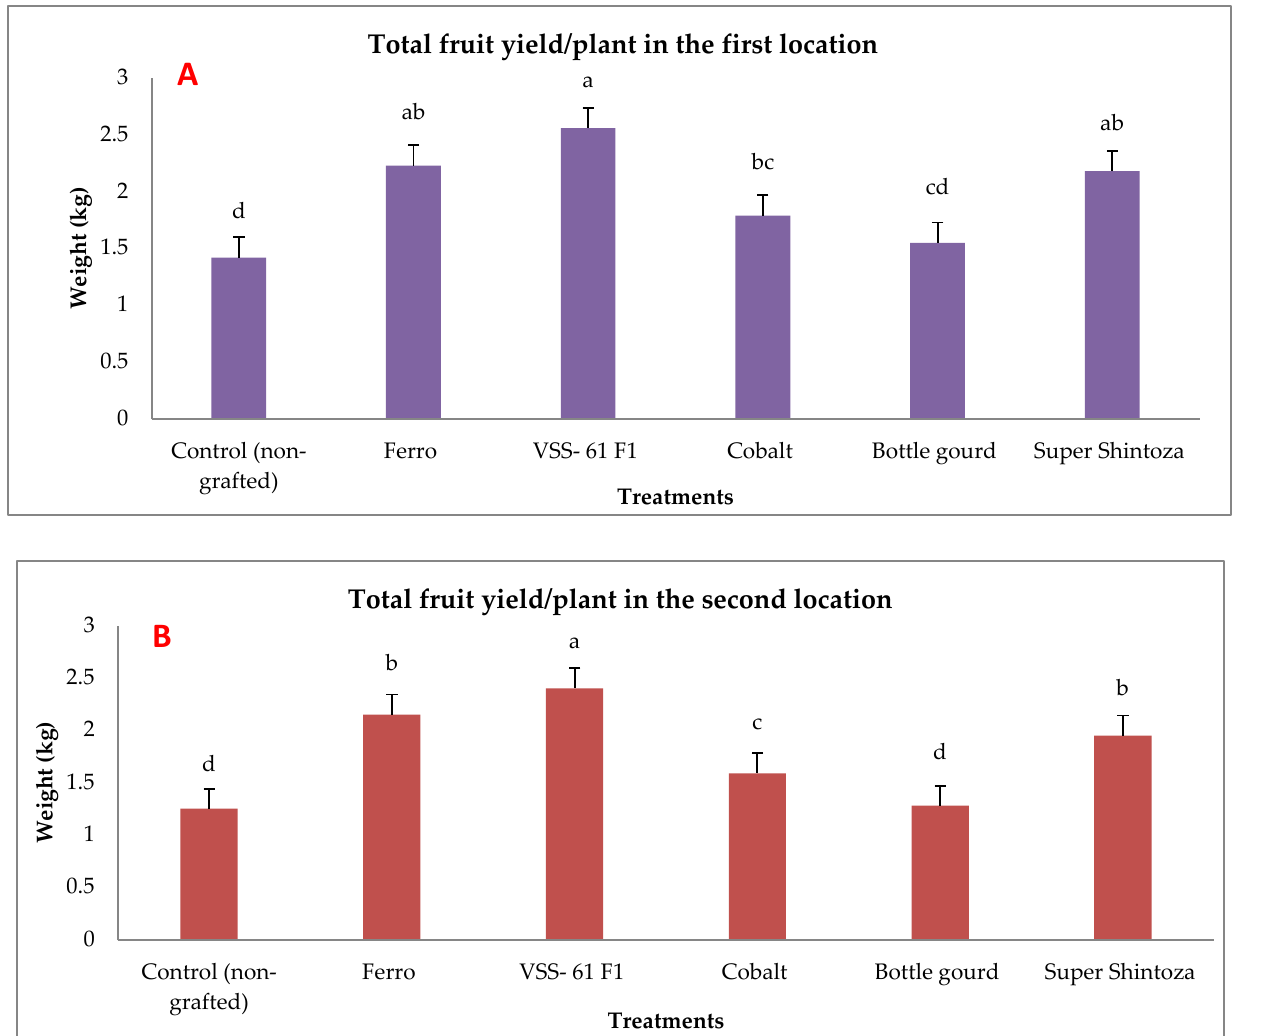
Figure 3. Effects of grafting onto different rootstocks on total fruit yield of cucumber (kg plant −1 ) under heat stress conditions in the first (A) and second location (B). Values are means ± standard deviation (SD) from three replicates. Different letters in the same column show significant differences among each group of treatments according to Duncan’s test at p ≤ 0.05.